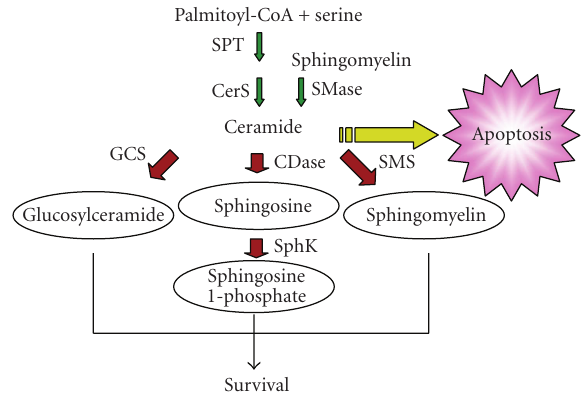
Figure 1: Ceramide Metabolism. Ceramide is produced de novo via serine palmitoyltransferase (SPT) and ceramide synthase (CerS), or from sphingomyelin via sphingomyelinase (SMase), and induces apoptosis. In turn, ceramide is metabolized via multiple mech- anisms, including glucosylceramide synthase (GCS), ceramidase (CDase) sphingosine kinase (SphK), and sphingomyelin synthase (SMS), with this metabolism of ceramide allowing cell survival.